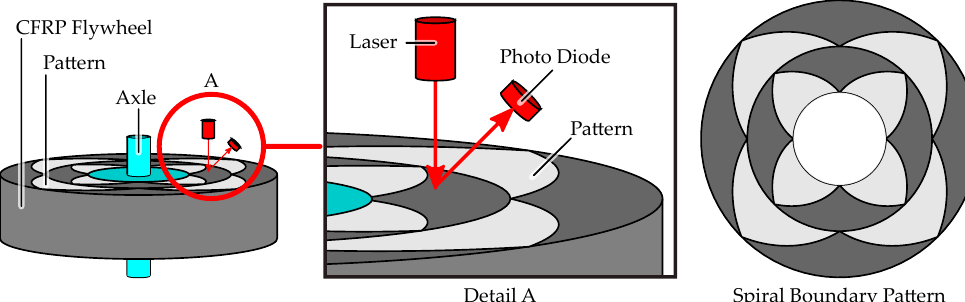
Figure 1. Basic operation principle of optoelectronic strain measurement (OESM) on a flywheel. A special pattern consisting of pieces of Archimedean spirals is applied to the rotor. The laser illuminates a spot on the rotor surface, and the photo diode is used to measure the reflected light.